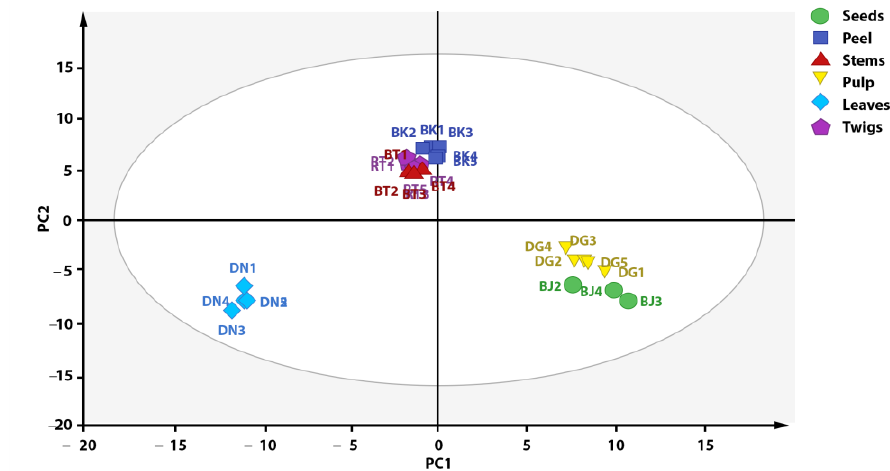
Figure 4. Distribution of antioxidant compounds in plant parts of X.